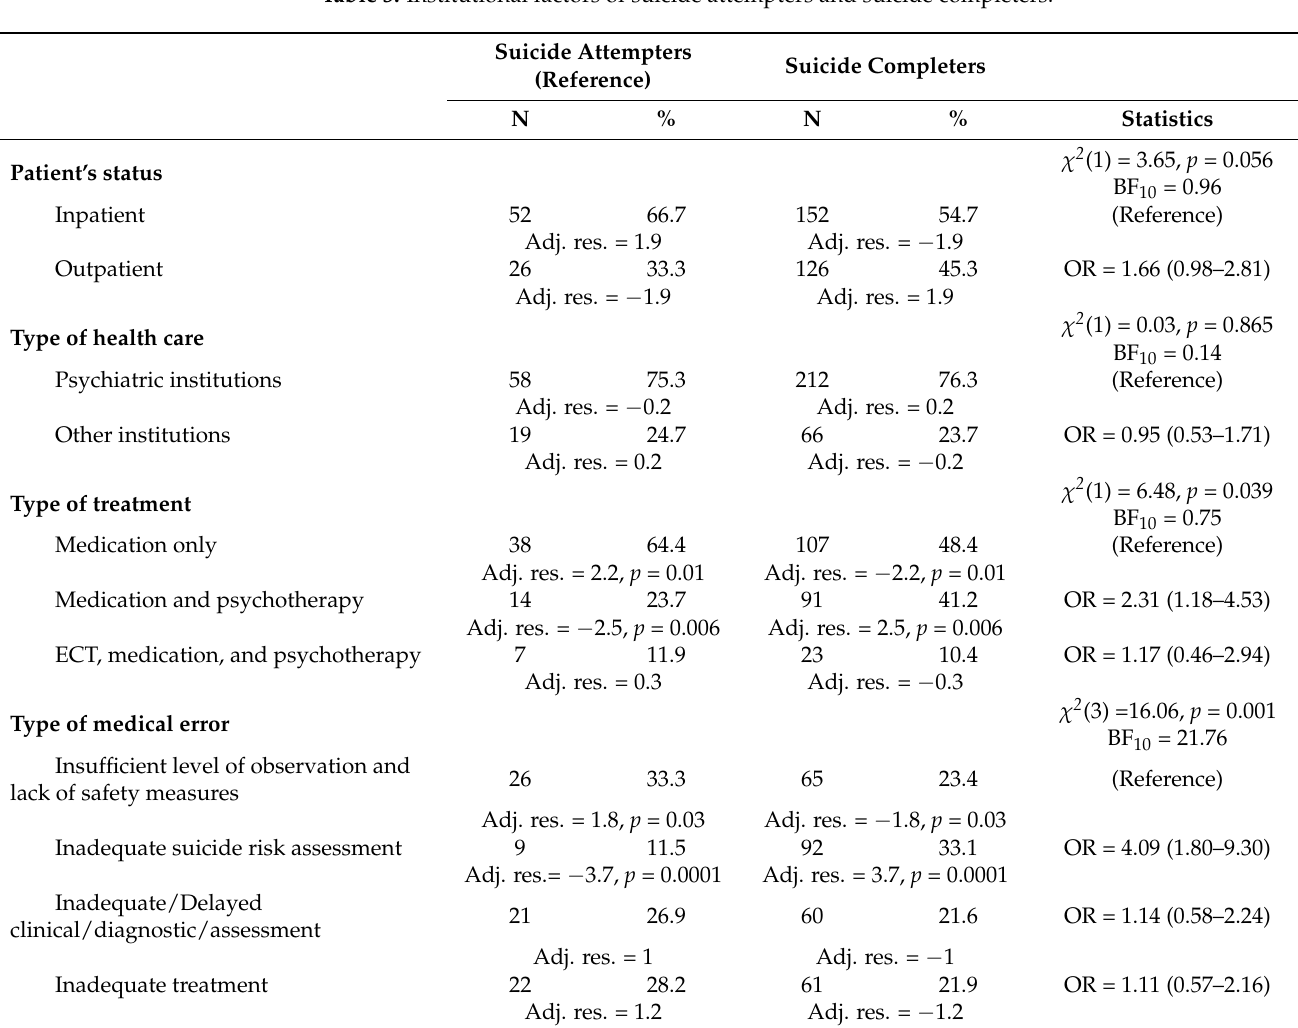
Table 3. Institutional factors of suicide attempters and suicide